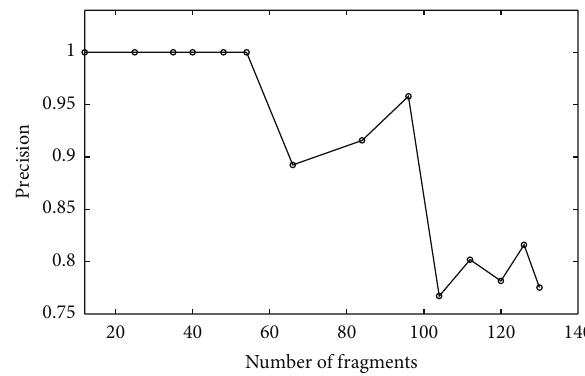
Figure 14: The precision of reconstructing the document (Figure 2) shredded into different pieces.